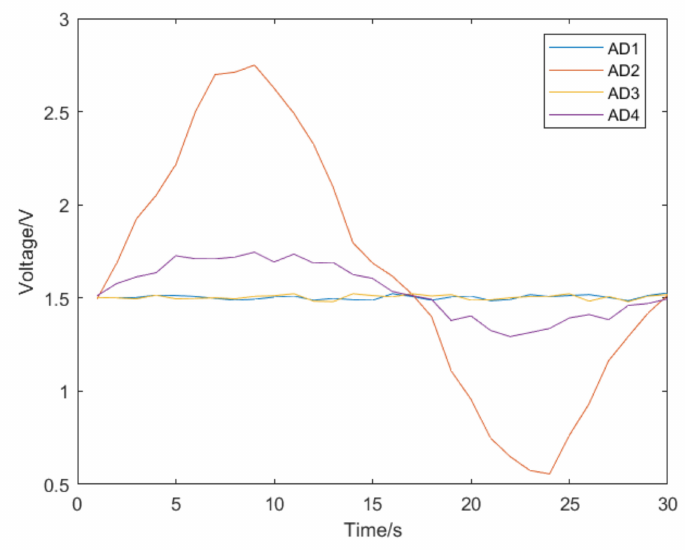
Figure 14. The voltage change during a catheter push after rotating the catheter by 90